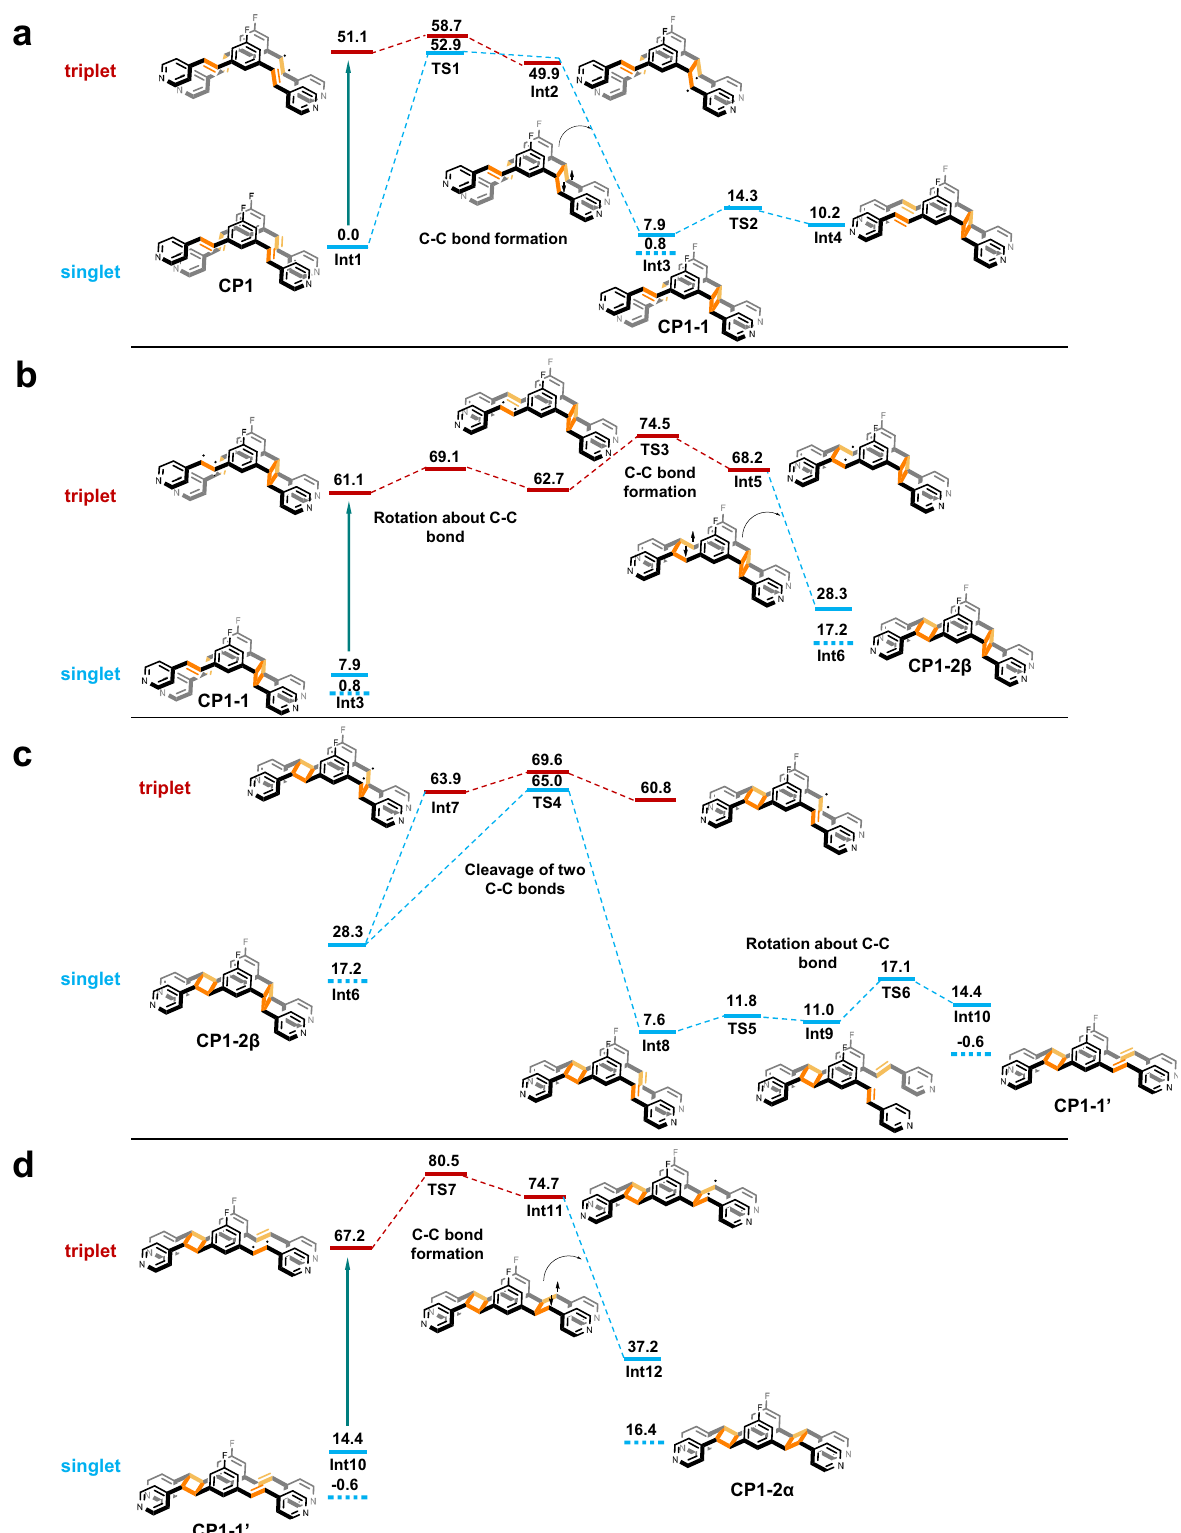
Fig. 4 Calculated energy pro fi les. a – d Reaction energy diagram (in kcal/mol) for the transformation processes from CP1 to CP1 - 1 , CP1 - 1 to CP1 - 2 β , CP1 - 2 β to CP1 - 1 ′ , and CP1-1 ′ to CP1 - 2 α . The thick bottle-green arrow signi fi es a step that requires photoexcitation. The thick blue dashed lines for Int3 , Int6 , Int10 , and Int12 are the relative energies obtained by using the respective X-ray structures when building the model in Supplementary Fig.